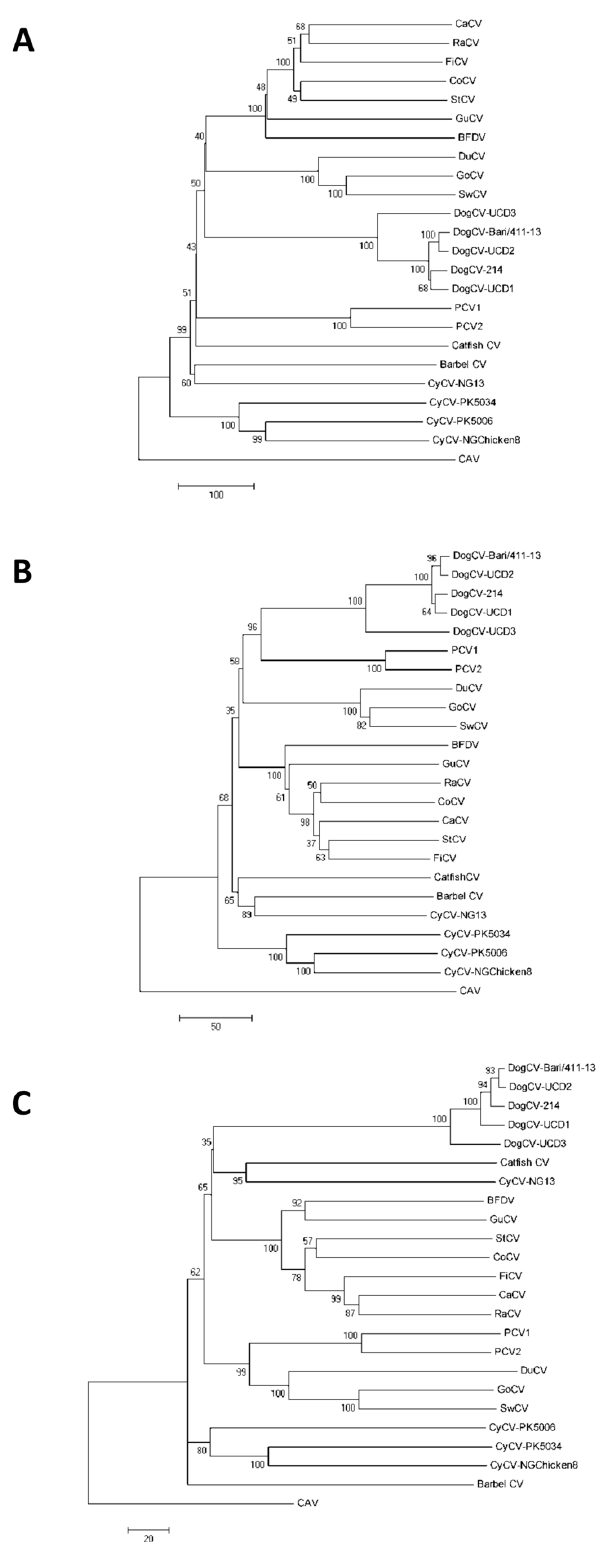
Figure 1. Phylogenetic analysis of DogCV strain Bari/411–13 and other circoviruses. Neighbor-joining trees are based on the full- length genome ( A ), replicase ( B ) and capsid ( C ) protein genes. For phylogenetic tree construction, the reference strains and GenBank accession numbers are as reported in Table 1. The